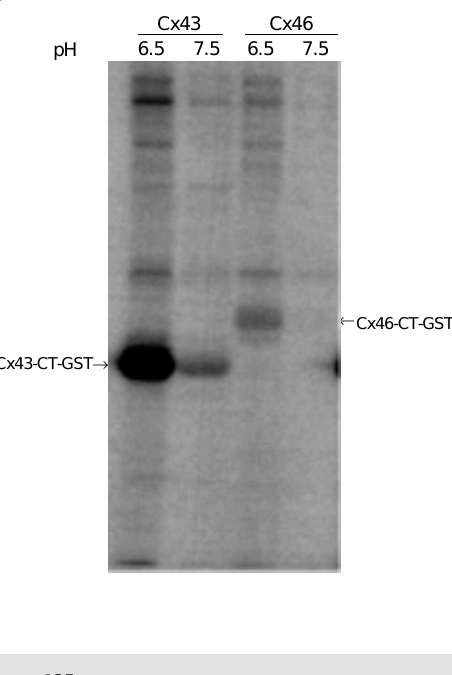
Figure 3 - Titration of pH in the in vitro kinase assay. In this as- say, the pH of either the binding or kinase reaction was held con- stant while the pH of the other reaction was varied. The phos- phorylation of the Cx43-CT-GST fusion protein was quantified by PhosphoImager analysis. Two lanes for each pH were quanti- fied and the results were aver- aged. The figure is representa- tive of three experiments. Panel A , The pH of the kinase reaction was held at either pH 6.5 (open bars) or pH 7.5 (closed bars) while the pH of the binding re- action was varied from 6 to 8 at 0.5-pH unit intervals. Panel B , The pH of the binding reaction was held at either pH 6.5 (open bars) or pH 7.5 (closed bars) while the pH of the kinase reac- tion was varied from 6 to 8 at 0.5-pH unit